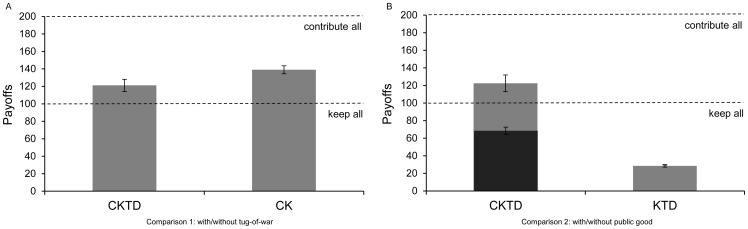
Participants' payoffs in all experimental conditions.Mean (± s.e.) payoffs in lab dollars (L$) per round (means are calculated over 10 rounds of each condition). If all players had contributed all of their money to the group resource each round, each player's payoff would be L$200; if all players had kept all of their money for themselves each round, each player's payoff would be L$100. (a) Comparison of games with and without the options for tug-of-war competition (CKTD and CK respectively). (b) Comparison of games with and without the option to contribute to a group resource (CKTD and KTD respectively). Black bar shows players' adjusted payoffs if money contributed to the group resource had not been doubled (i.e., if k = 1).